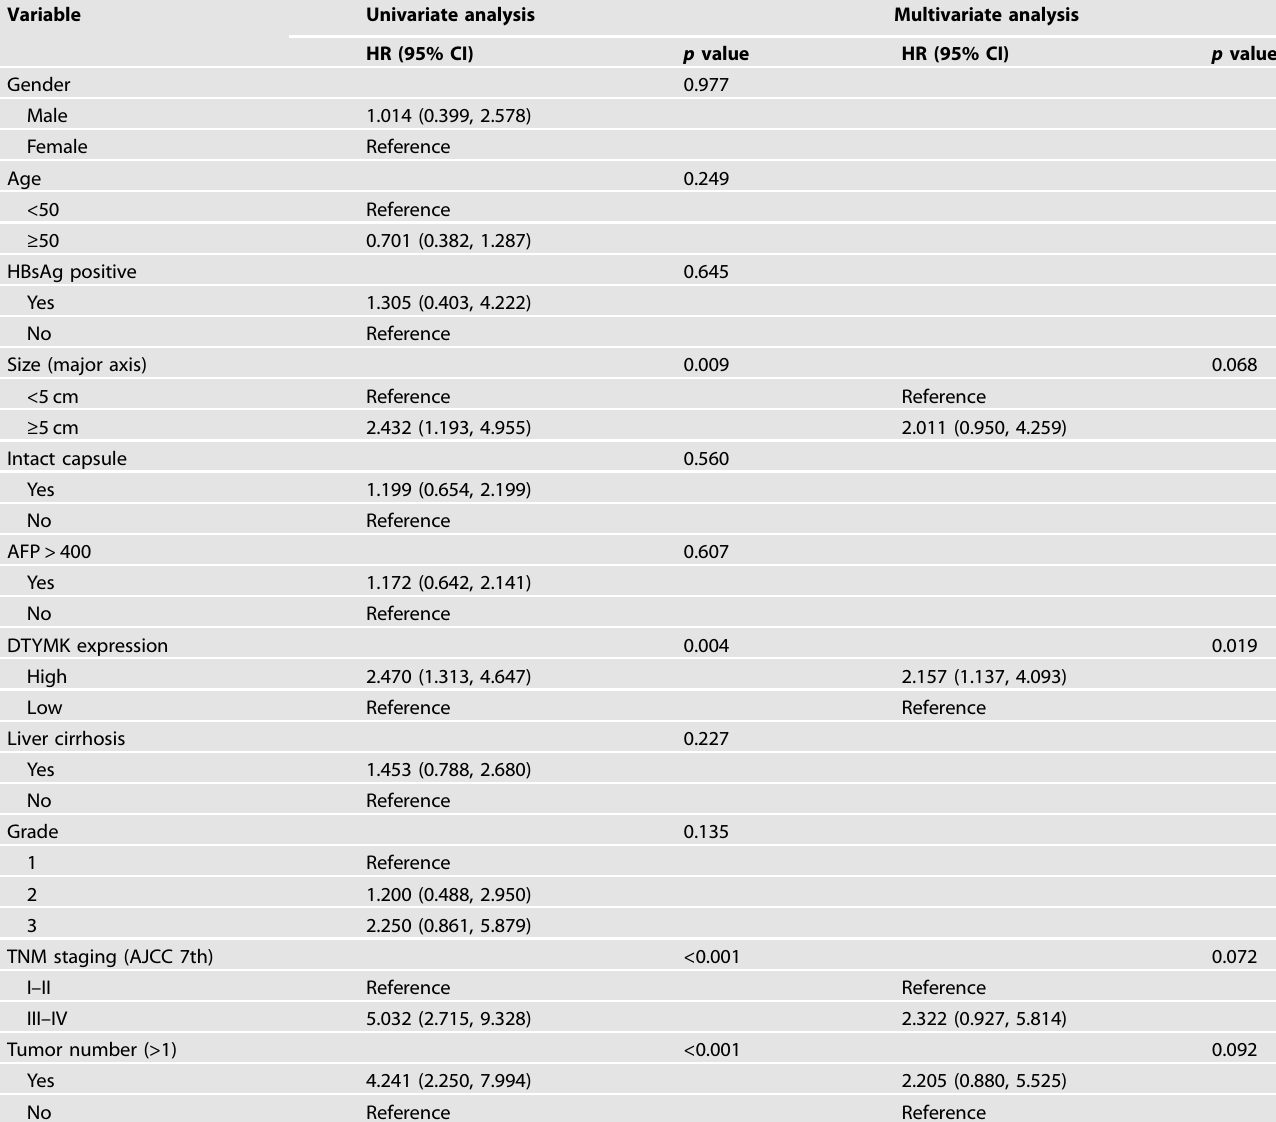
Table 1. Univariate and multivariate Cox regression